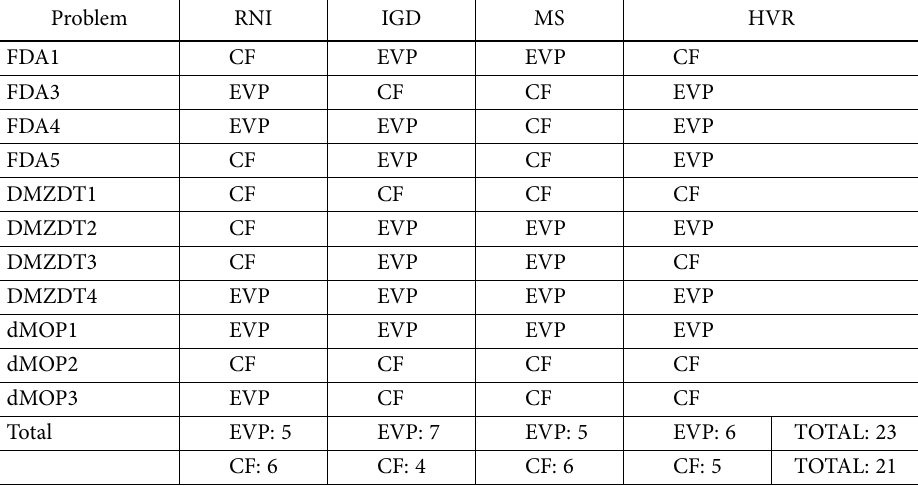
Table 1. Best configuration of DPEM_HH for each DMOP for all metrics and sum of best ranking